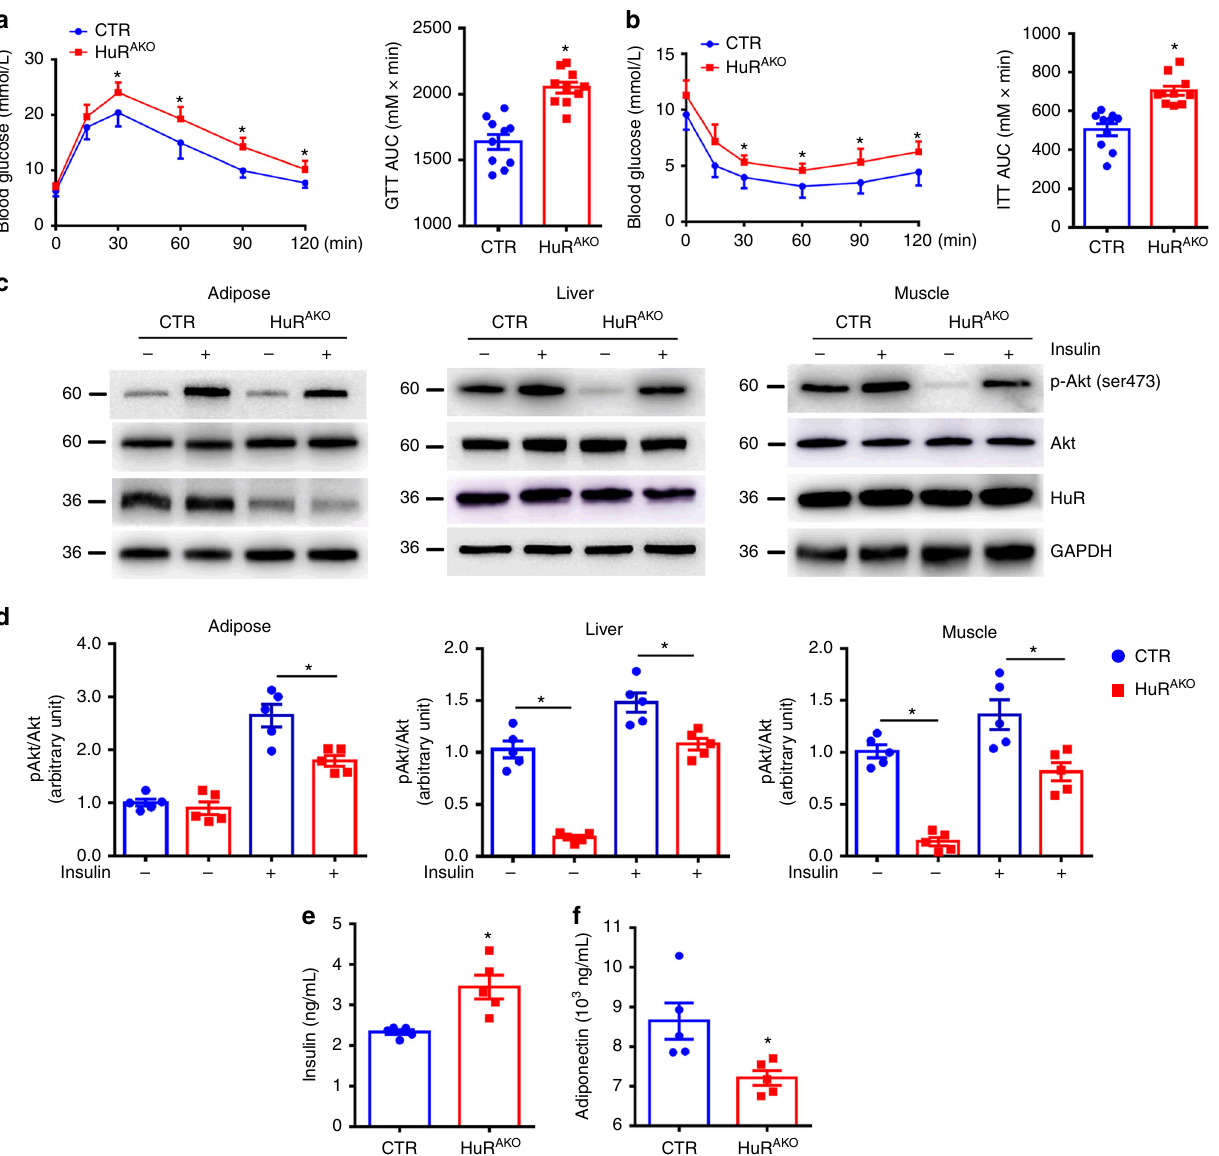
Fig. 6 Adipose-speci fi c HuR deletion exacerbates insulin resistance. a , b Glucose tolerance test ( a ) and insulin tolerance test ( b ) in control and HuR AKO mice fed an HFD ( n = 10), *comparison of HuR AKO vs. control. Right panel, area under curve. c , d Western blot analysis of Akt phosphorylation and HuR in adipose tissue, liver and muscle of control and HuR AKO mice with HFD. Protein levels were normalized to GAPDH level ( n = 5), *comparison of HuR AKO vs. control. e , f Serum insulin and adiponectin levels in overnight-fasted control and HuR AKO mice fed an HFD ( n = 5), *comparison of HuR AKO vs.